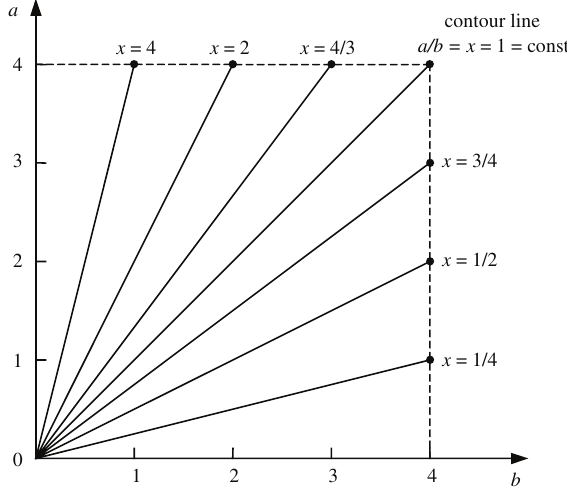
Fig. 4. Contour lines of constant values of the quotient a / b = x in the 2D-space A × B